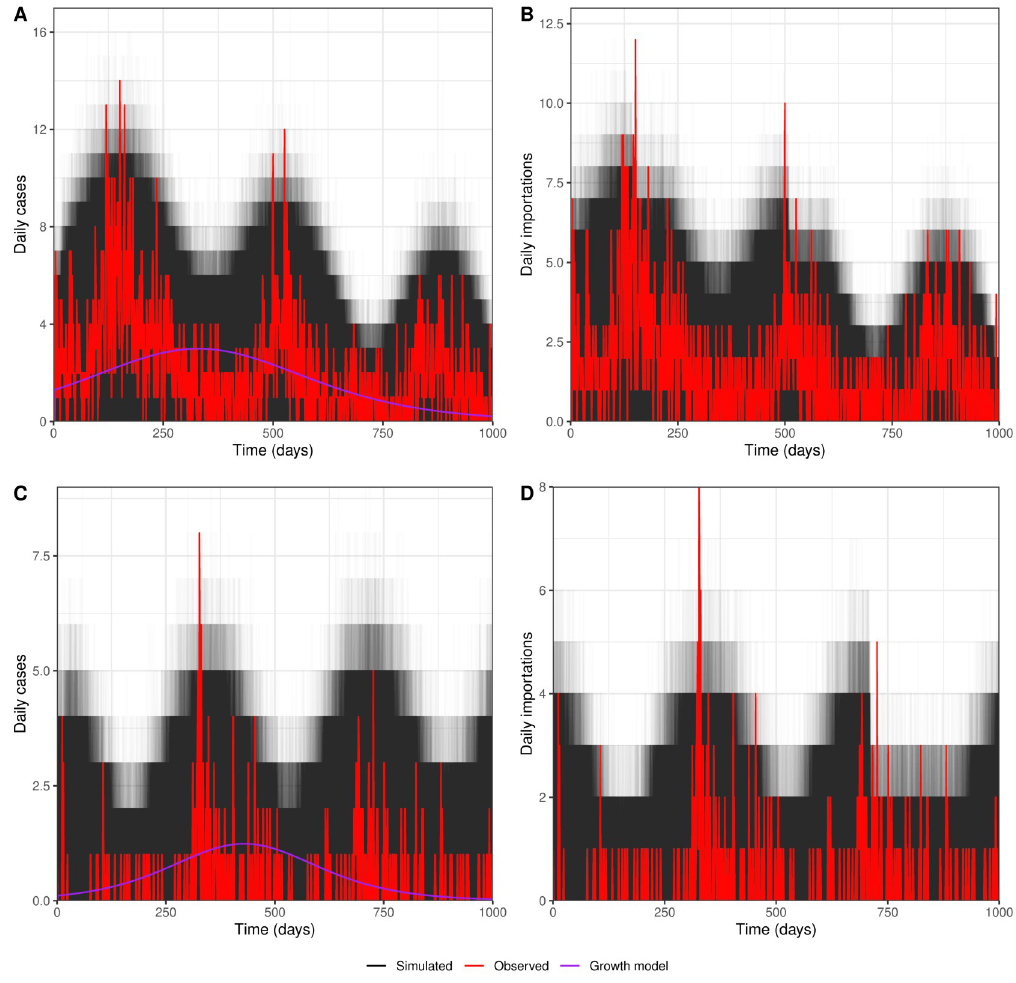
Fig 5. Simulated daily cases for the China and Eswatini data. Fig 5A and 5C show the daily malaria case counts for China and Eswatini respectively. The red line shows the real case counts over time and the black lines show the case counts over time from 10,000 simulations of the full fitted model. Fig 5B and 5D the daily importations for China and Eswatini respectively. Again the red line shows the real case counts over time and the black lines show simulation results.